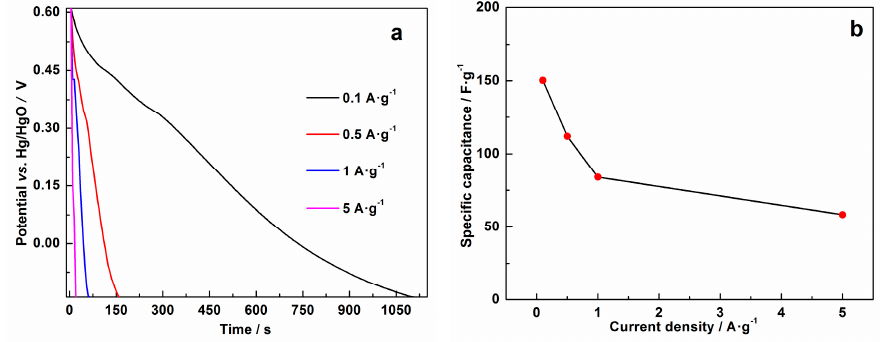
Figure 8. ( a ) Galvanostatic charge-discharge curves of the MnO 2 @MnO 2 electrode at different current densities of 0.1, 0.5, 1 and 5 A·g − 1 , respectively; and ( b ) variation in specific capacitance with current density obtained based on Figure 8a.